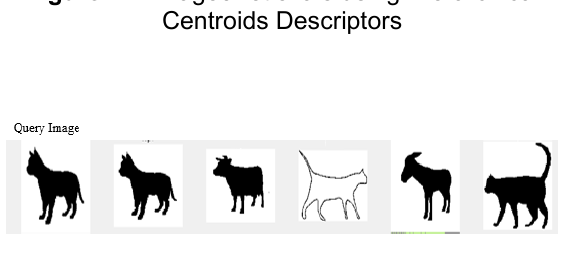
Figure 11. Image3 retievals using Hierarchical Centroids Descriptors